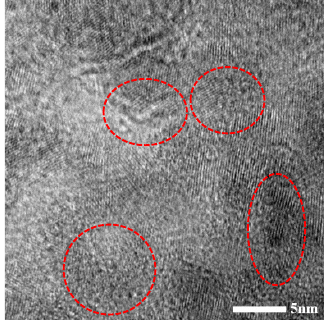
Figure 7. HRTEM image of the alloy after ageing treatment at 450 °C for 60 min.